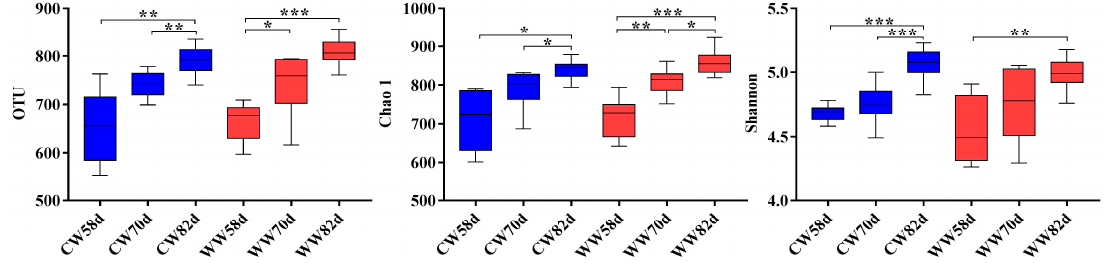
Figure 4. Effects of drinking WW on the diversity of the cecal bacterial community ( n = 9–15). CW, cold water group; WW, warm water group. Values are shown as means ± SEM. Differences were analyzed by one-way analysis of variance followed by the least-significant difference post hoc test. * p < 0.05, ** p < 0.01, *** p < 0.001.